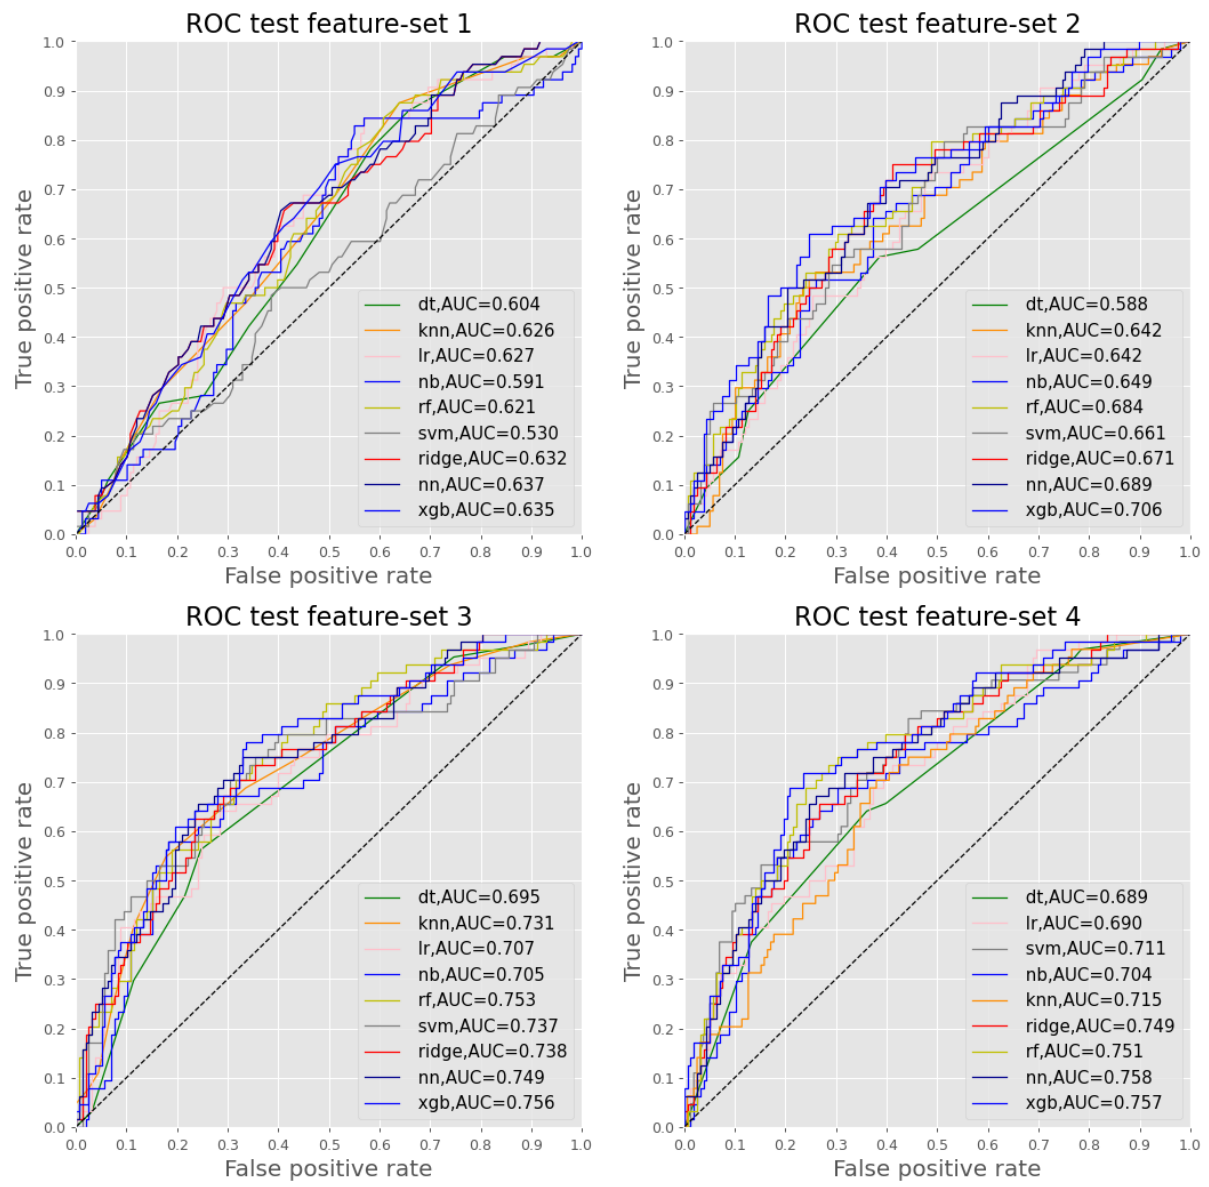
Figure 2. Test accuracy of the 9 machine learning algorithms using feature sets 1 to 4. AUC: area under the receiver operating curve; dt: decision tree; knn: K-nearest neighbors; lr: logistic regression without penalization; nb: naive bayes; nn: neural network; rf: random forest; ridge: ridge regression; ROC: receiver operating curve; svm: support vector machine; xgb: eXtreme gradient